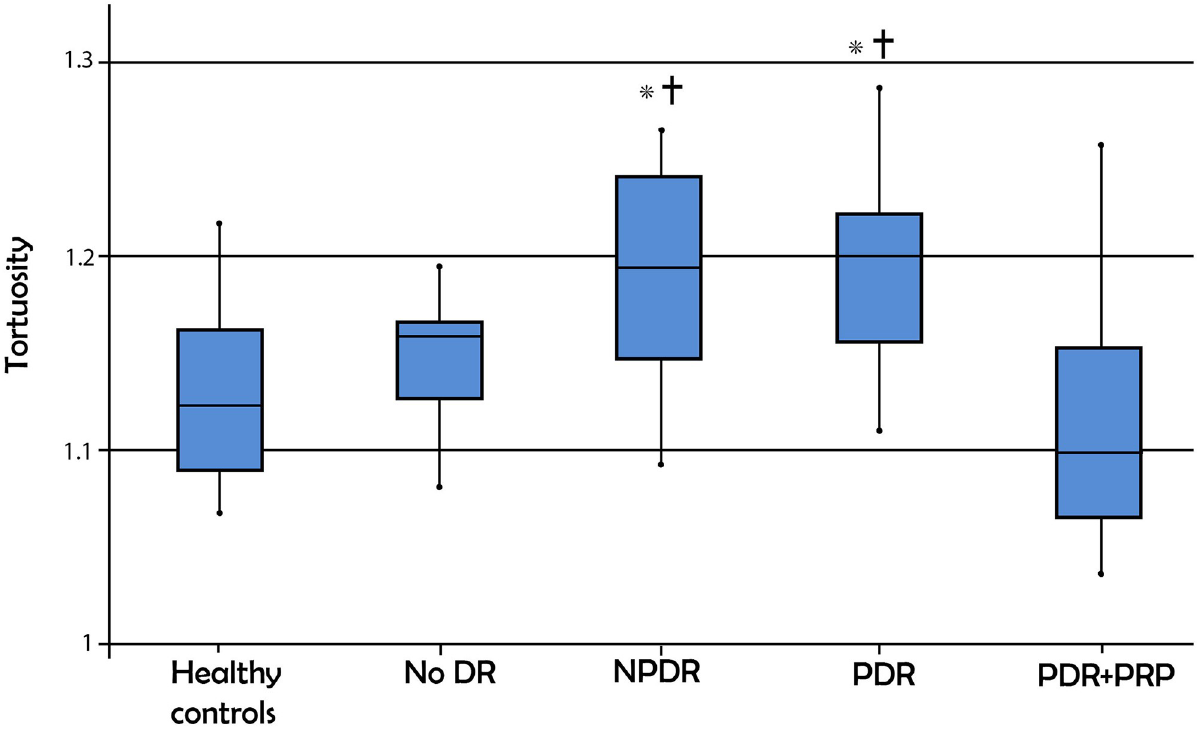
Fig 2. Box plot representation of the perifoveal vessel tortuosity results in the five study groups. No DR: No diabetic retinopathy, NPDR: Non- proliferative diabetic retinopathy, PDR: Proliferative diabetic retinopathy, PRP: Panretinal photocoagulation, PDR+PRP: Proliferative diabetic retinopathy receiving panretinal photocoagulation. (p < 0.05, � significant vs Healthy controls, † significant vs